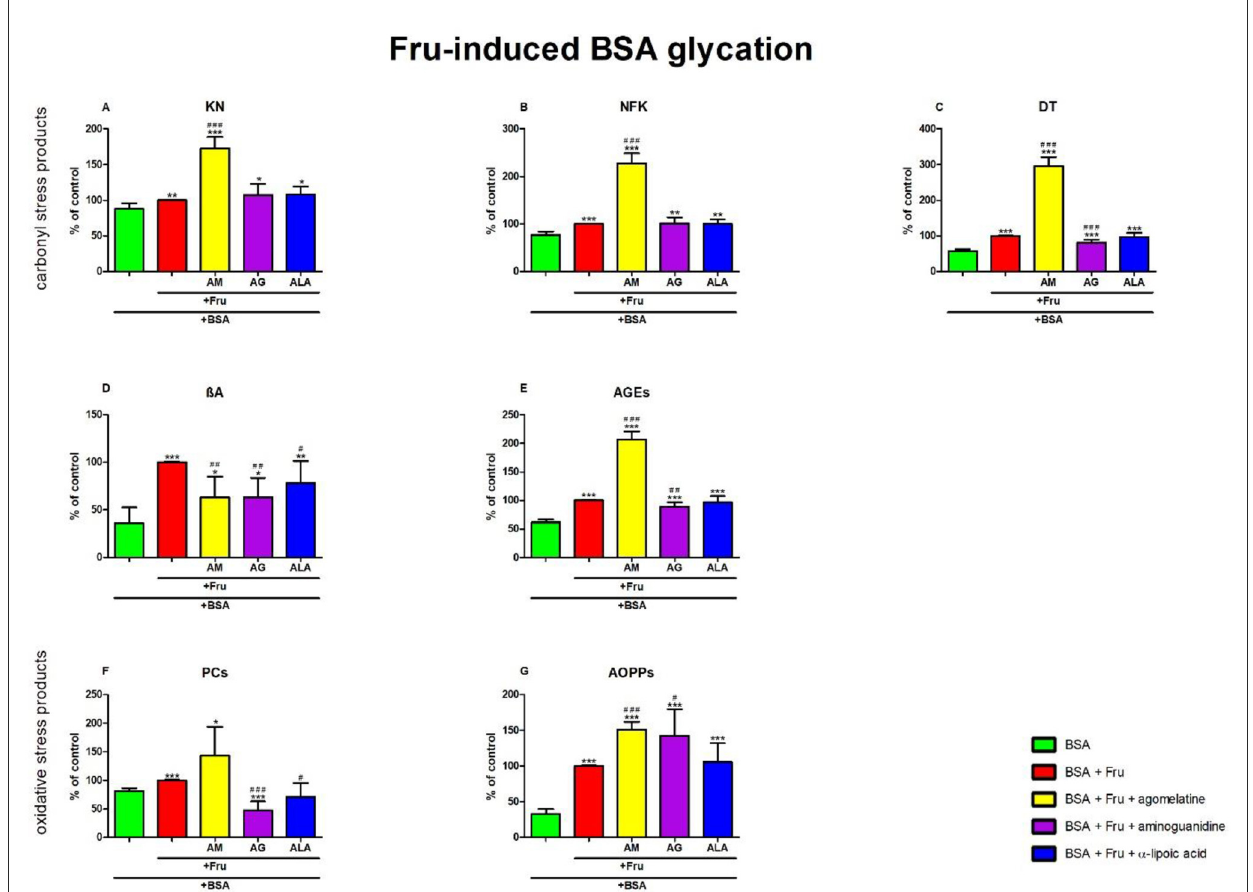
FIGURE6 Effects of agomelatine addition to fructose (Fru)-glycated bovine serum albumin (BSA) on carbonyl stress products (A–E) and oxidative stress products (F, G) . AG, aminoguanidine; AGEs, advanced glycation end products; ALA, α -lipoic acid; AM, agomelatine; AOPPs, advanced oxidation protein products; β A, β -amyloid; BSA, bovine serum albumin; DT, dityrosine; Fru, fructose; KN, kynurenine; NFK, N-formylkynurenine; PCs, protein carbonyls. * p < 0.05 vs. negative control (BSA); ** p < 0.01 vs. negative control (BSA); *** p < 0.001 vs. negative control (BSA); # p < 0.05 vs. positive control (BSA + Fru); ## p < 0.01 vs. positive control (BSA + Fru); ### p < 0.001 vs. positive control (BSA +